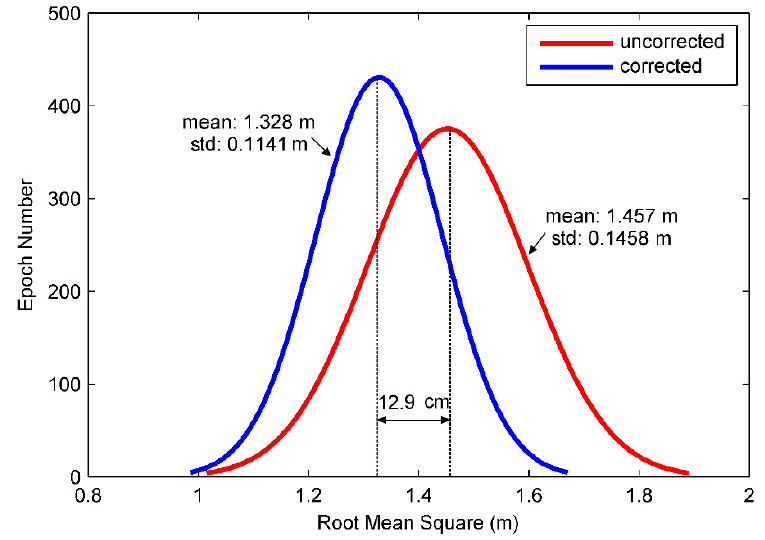
Figure 16. Distribution of root-mean-square error in single point positioning.